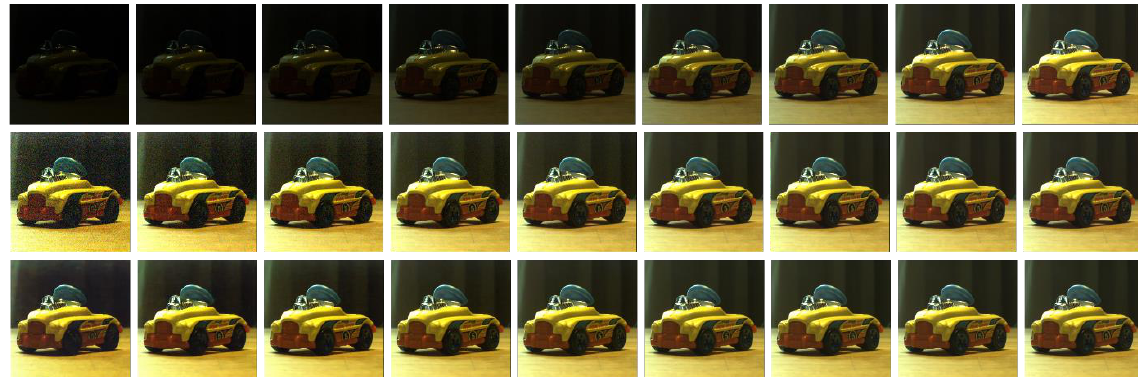
Figure 9. Acquisitions from 1.11 ms to 50 ms. Top: Original images; Middle; LIP stabilization; Bottom: LIP + CNN denoising.